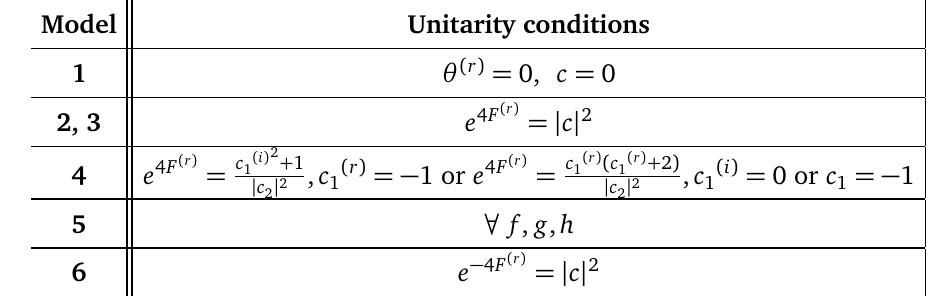
Table 6: Conditions on the functions and the constants of the full Hamiltonian H of models 1-6 to make them verify [ H , H † ] = 0. We put the superscripts ( r ) and ( i ) to identify the real and the complex part of the functions and